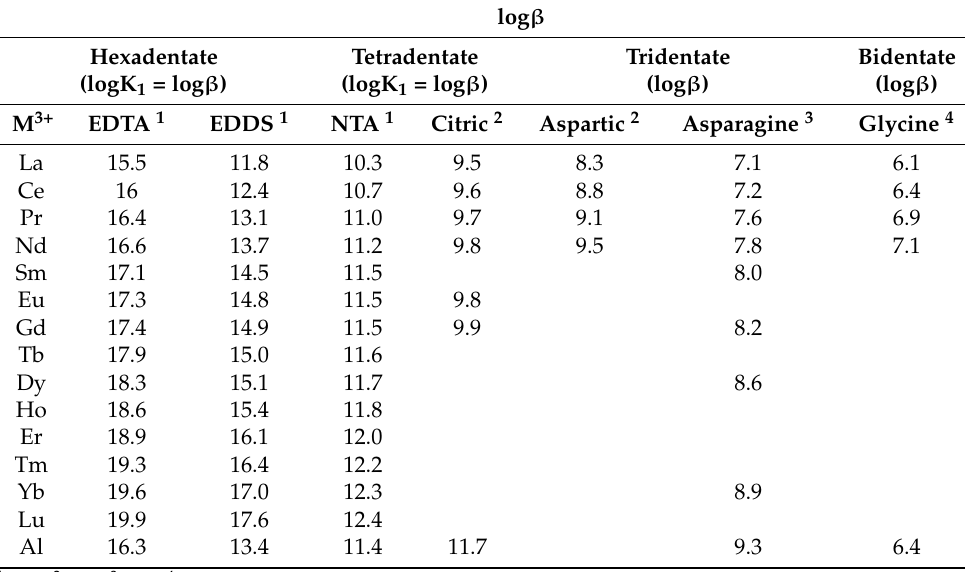
Table 1. Constants of formation (log β ) for complexes of trivalent rare earth ions and aluminum with the chelating agents employed in the present study (25 ◦ C, 1 atm, 0.1 mol/L KNO 3 ionic